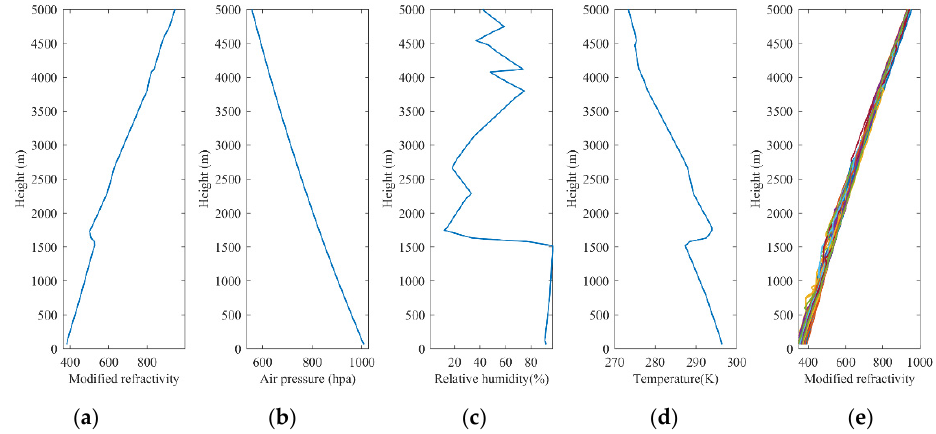
Figure 3. Radiosonde sounding data at 12:00 on 27 March 2019 ( a – d ) and the M -profiles for March 2019 ( e ).